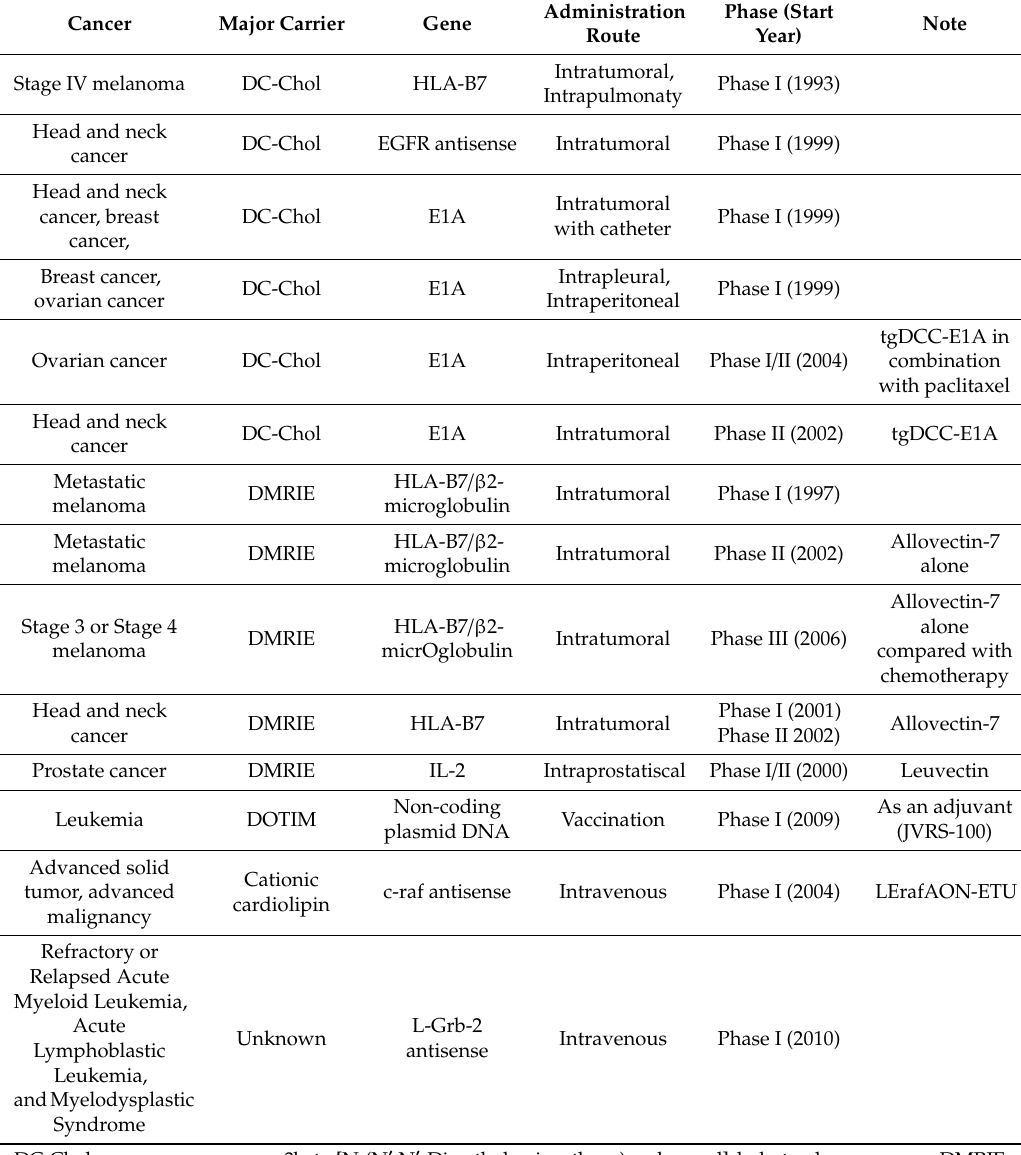
Table 2. Liposome-mediated clinical trials for cancer gene therapy